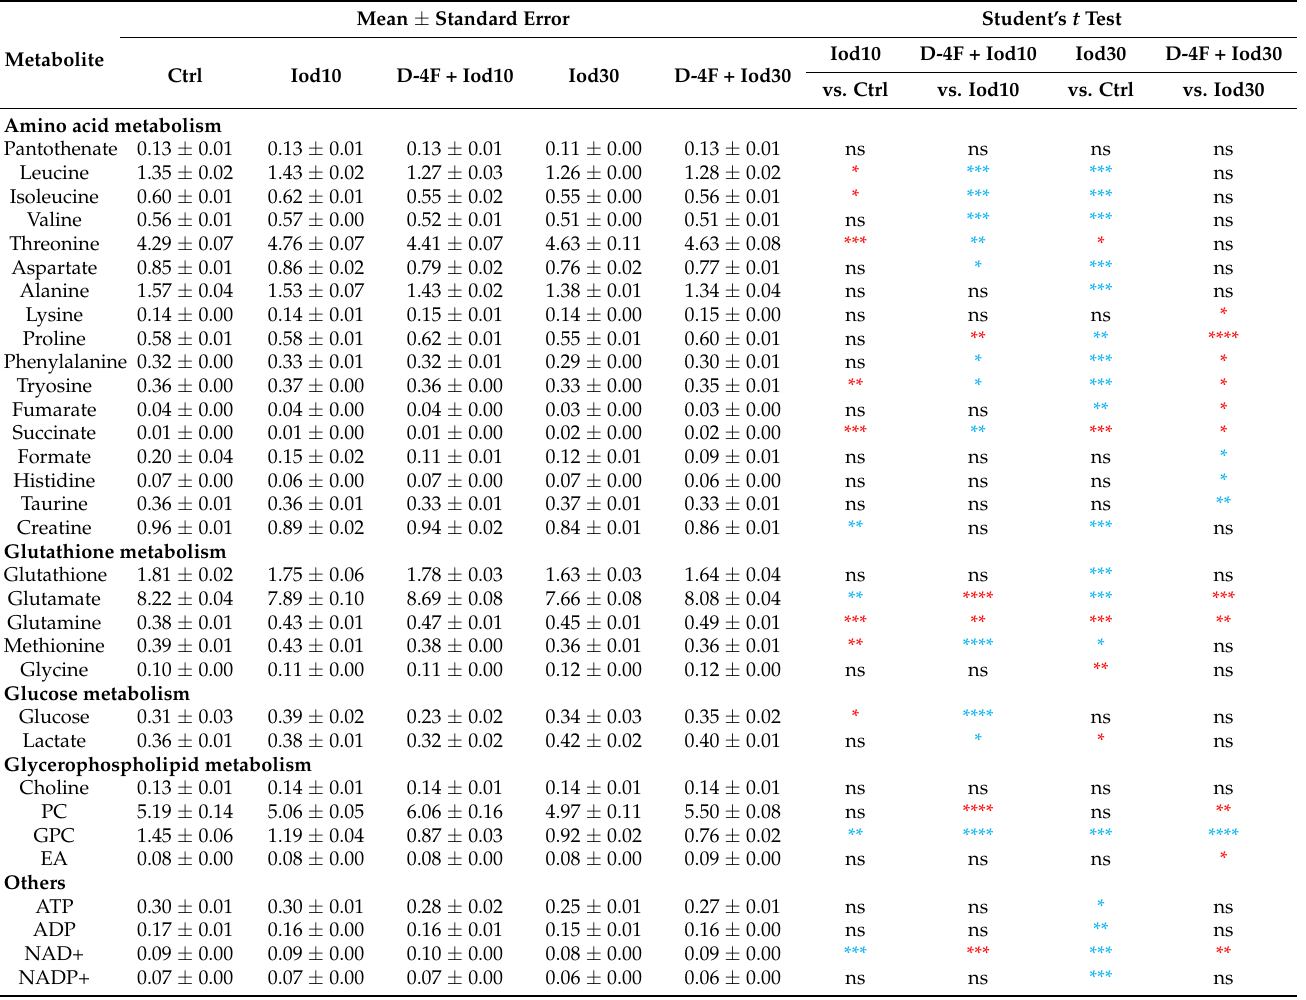
Table 1. Pair-wise comparisons of the metabolite levels between the five groups of HUVECs using Student’s t test. Mean ± Standard Error Student’s t Test Metabolite Amino acid metabolism Pantothenate 0.13 ±